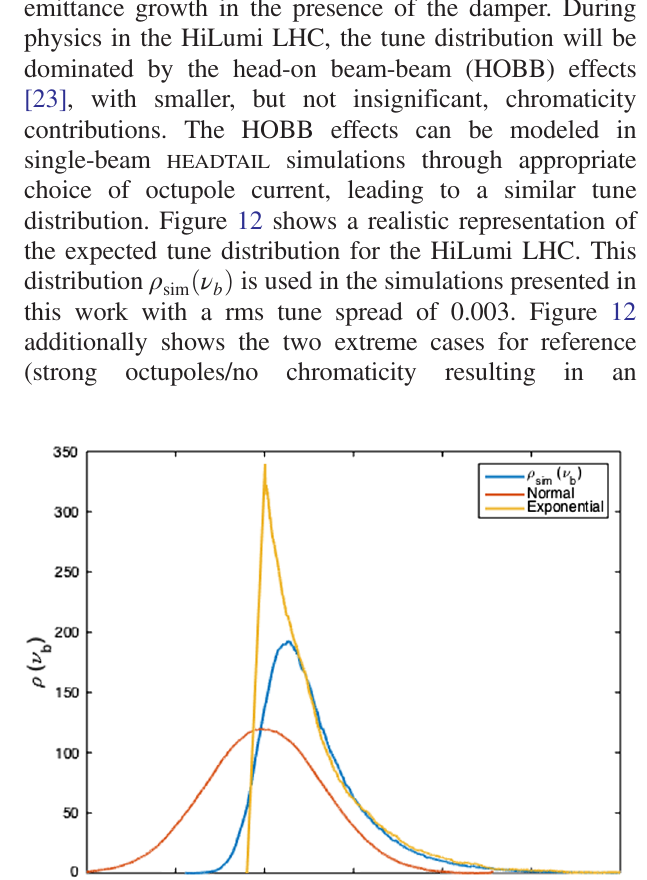
with the same b Þ